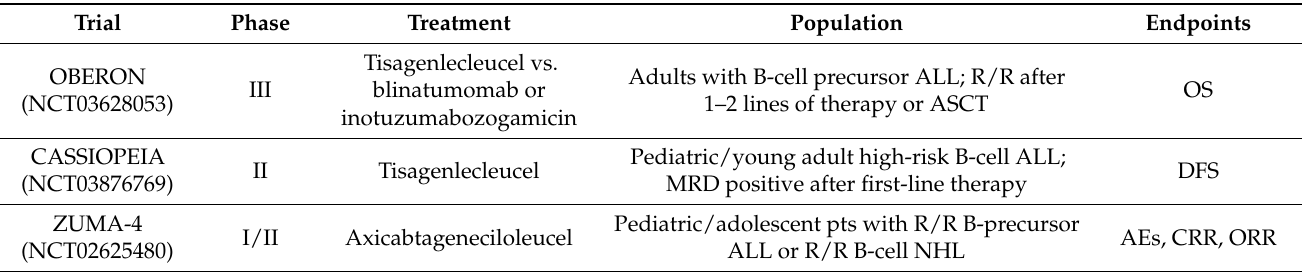
Table 4. Select ongoing trials with CAR T-cell therapy for patients with ALL relapsed/refractory B acute lymphoblastic